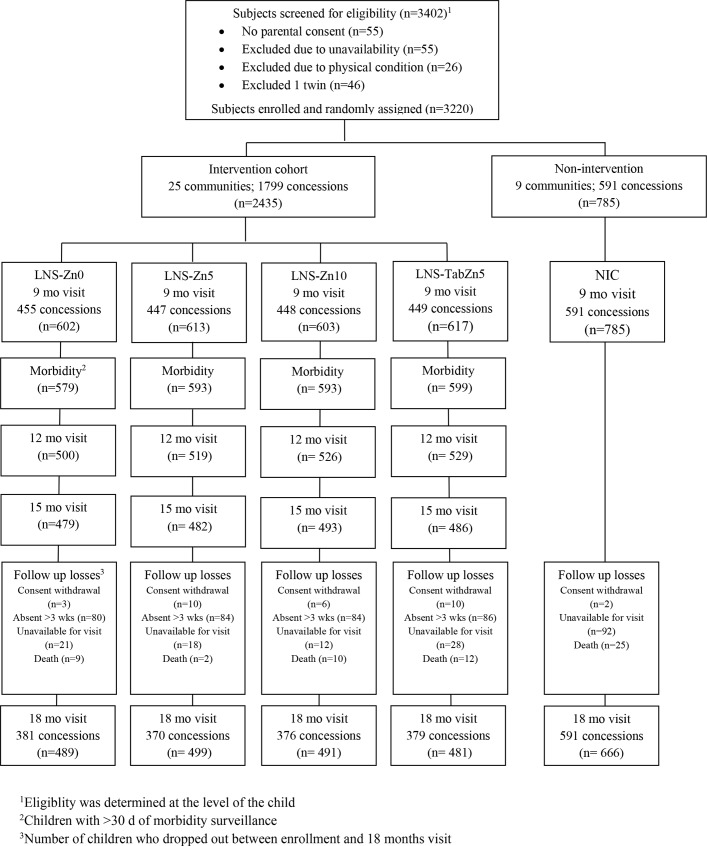
Flow diagram of clusters and participant progression through the iLiNS-ZINC trial.